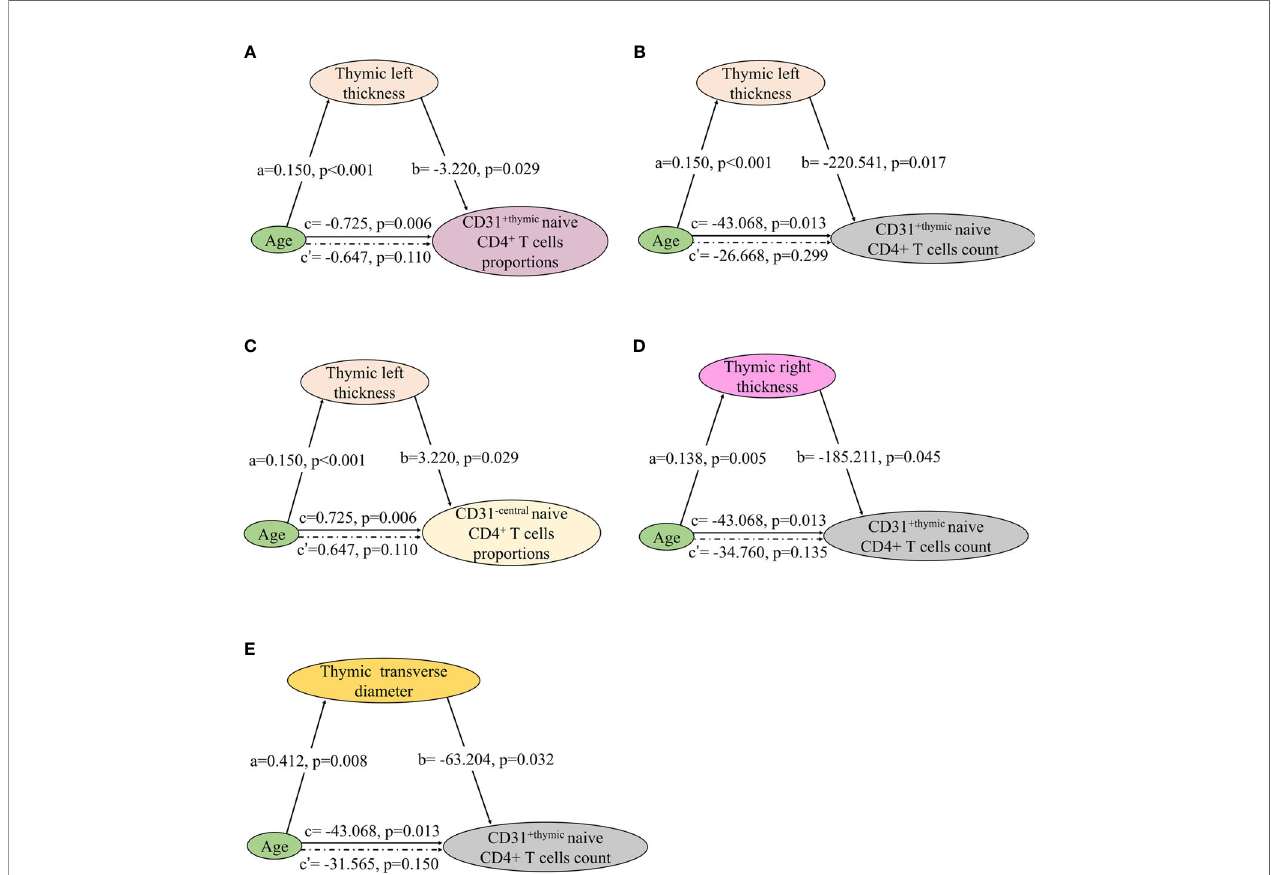
FIGURE 8 | Mediation effects of changes in thymic predominant sides on the association of decline in NMOSD thymic output naive CD4 T cells with age. (A – E) Mediation analysis was performed to examine the potential indirect relationship between Age (X) and thymic output naive CD4 T cells (Y) via the thymic predominant sides (M). Path a and path b indicate the association between X and M, and M and Y, respectively. Path c represents the total effect of X on Y, and path c ’ shows the direct effect of X on Y after controlling for mediating factor. X, predictor variable; Y, outcome variable; M,